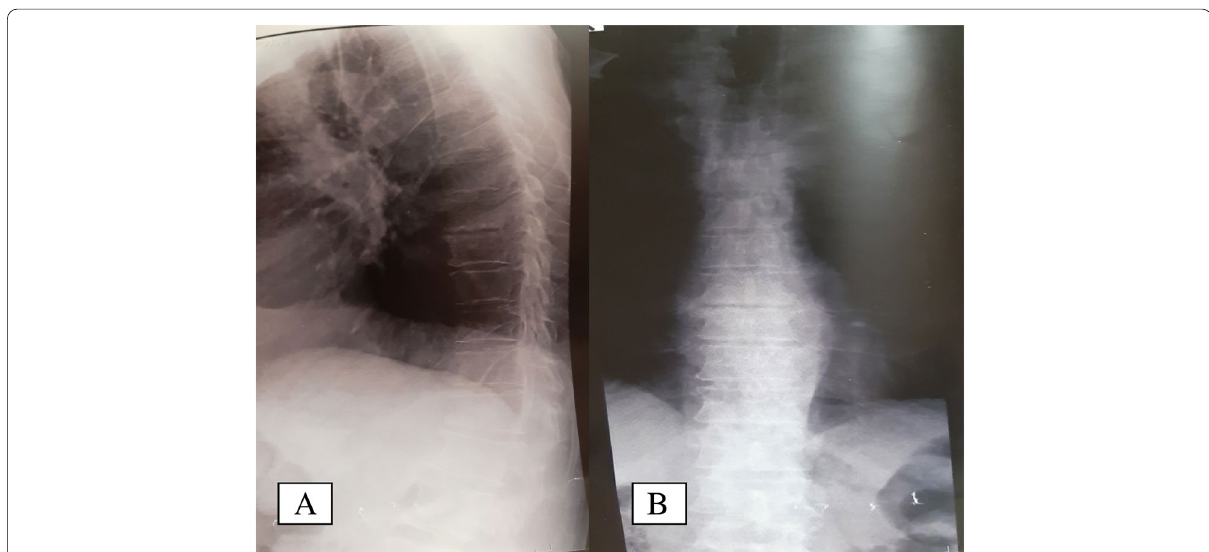
Fig. 1 The lumbar spine radiography at the front ( A ) and side ( B ) incidence: disc pinch with erosions of the D5-D6 and D8-D9 vertebral plates